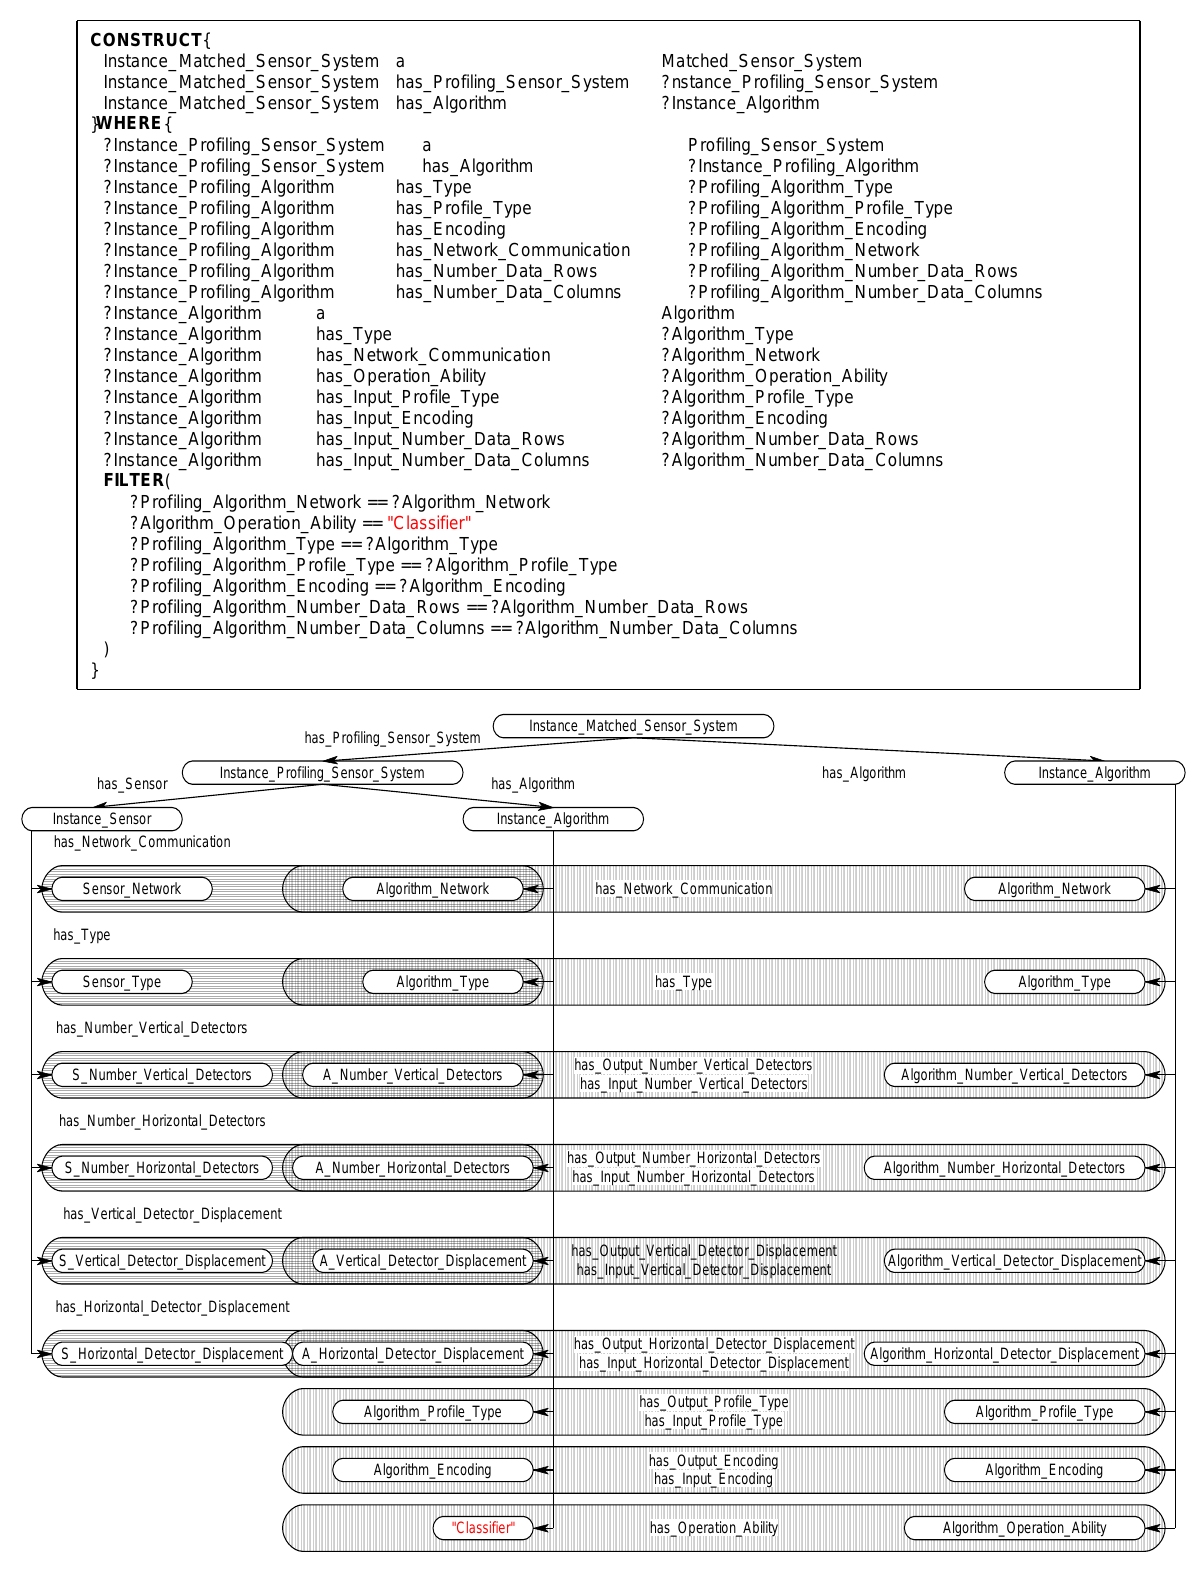
Figure 19. Sample Matched_Sensor_System rule and instance diagram, which returns an instance if the Profiling_Sensor_System instance and Algorithm instance properties: network communication, types, encoding, classification, data rows, and columns properties are